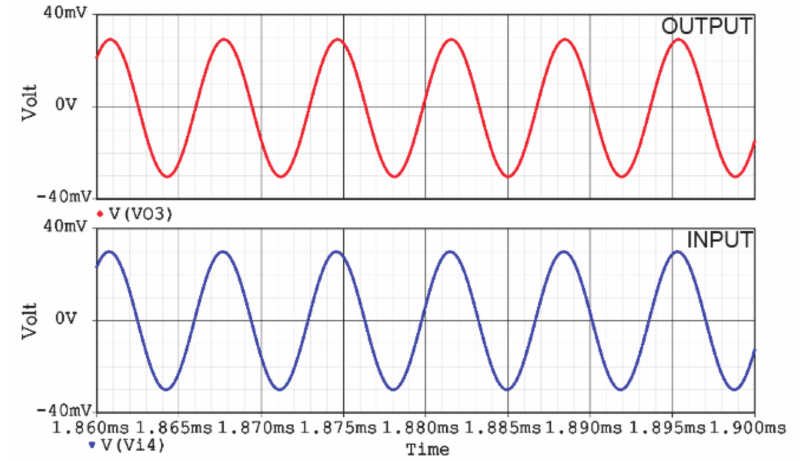
Figure 16. Time-domain BPF input and output voltage signals.